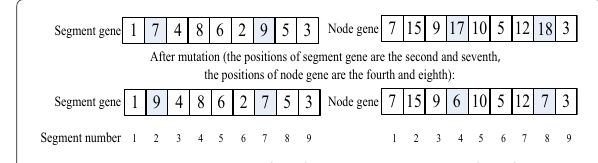
Fig. 9 Mutation operator used in the segment gene and node